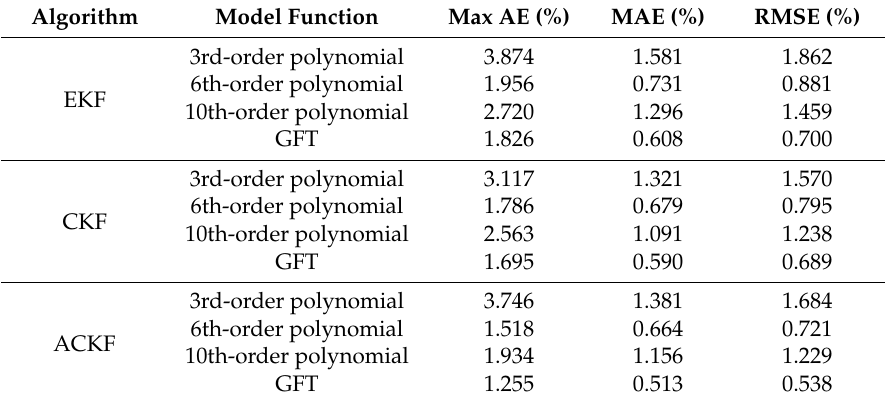
Table 5. Error analysis of SOC estimation results.